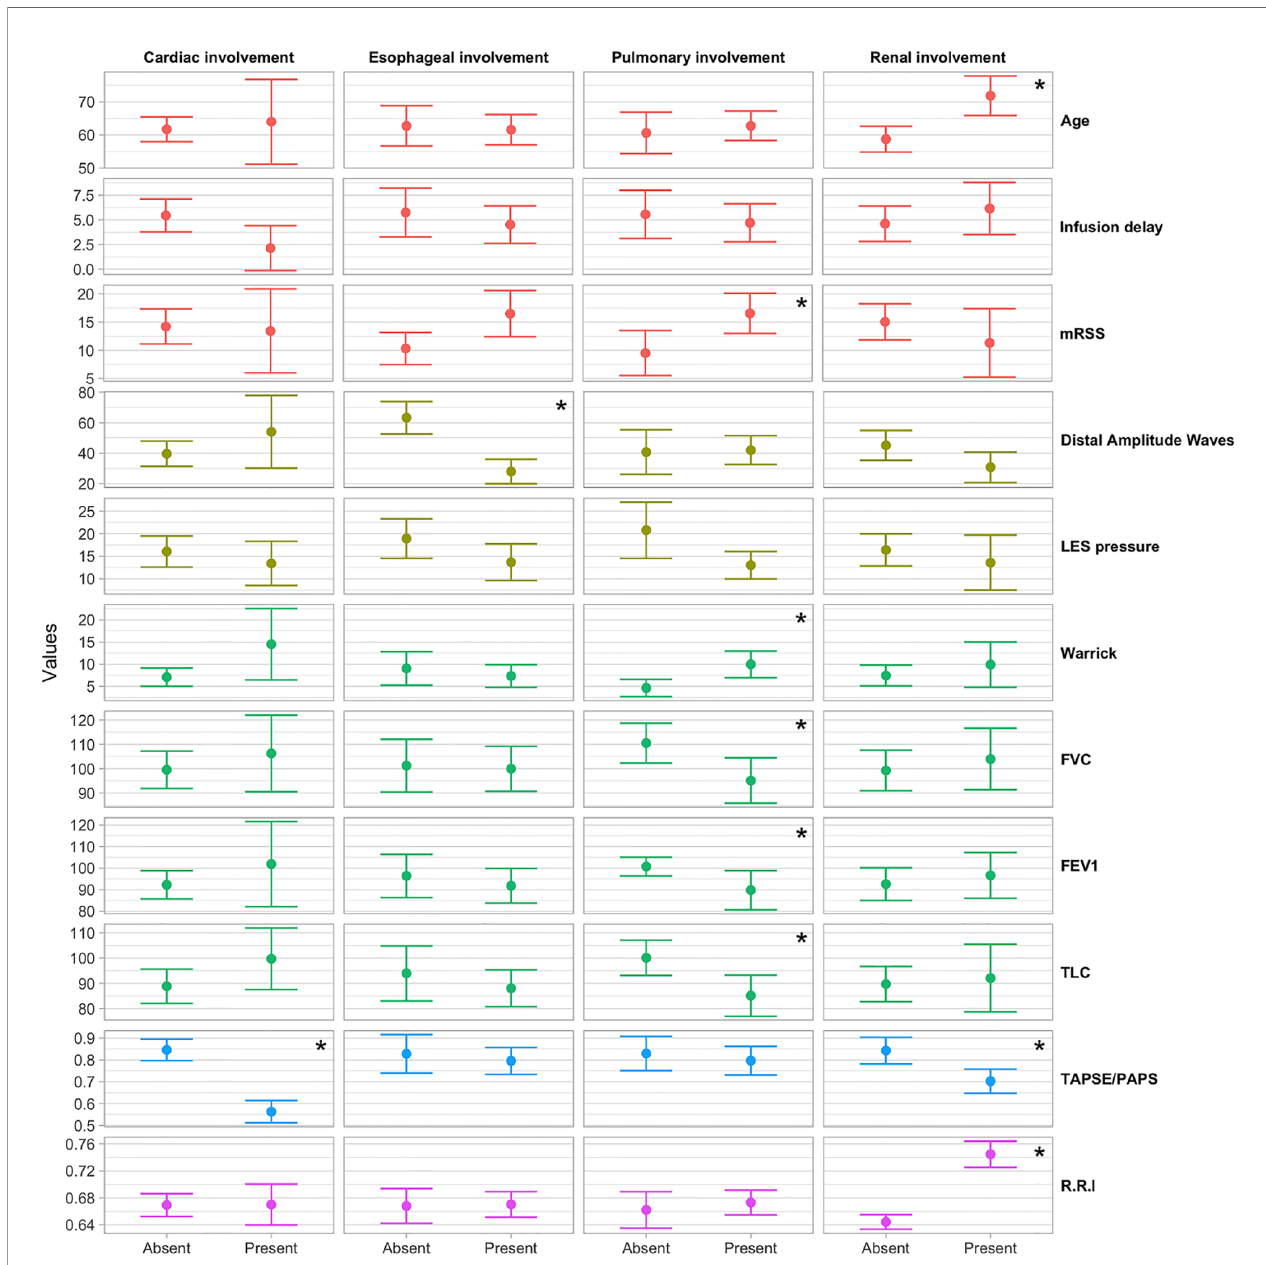
FIGURE 1 | Box plot of the distribution of instrumental parameters by the occurrence of heart, esophagus, kidney and pulmonary involvement. *p <